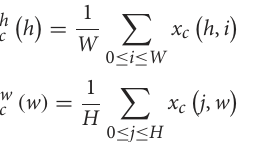
TABLE 1 Network parameters setting. Parameters Values Optimizer SGD Initial learning rate 0.001 Momentum 0.9 Weight decay 0.0001 Learning rate change